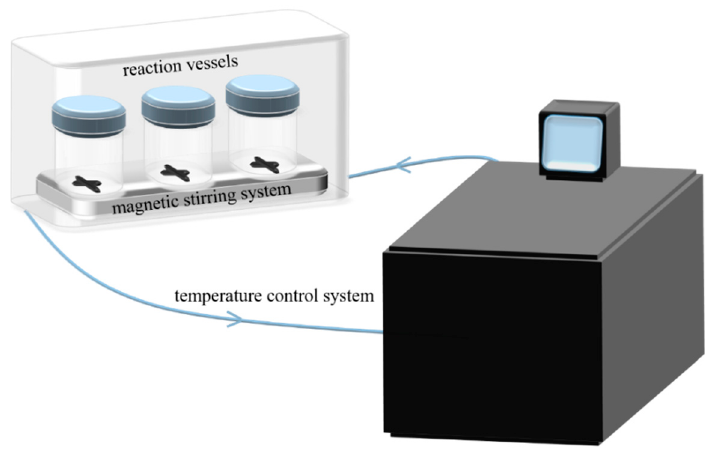
Figure 1. Schematic diagram of the experimental apparatus.